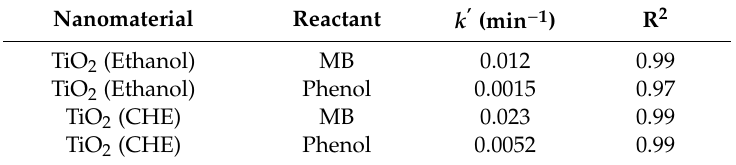
Table 2. Kinetic parameters obtained from first order fitting the experimental points of Figures 7 and 8. Nanomaterial